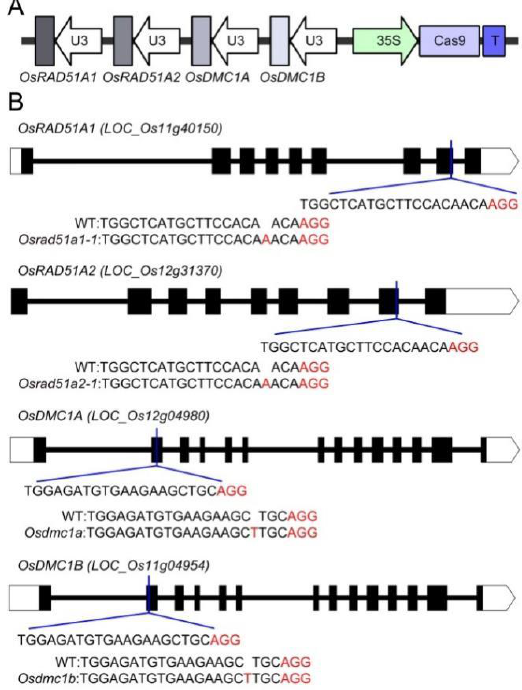
Figure 1. Targeted mutagenesis of OsRAD51 and OsDMC1 using the CRISPR/Cas9 genome editing system. ( A ). Strategy of vector construction for editing the rice RAD51 and DMC1 genes. ( B ). Regions in OsRAD51 exon 8 and OsDMC1 exon 2 were targeted by the CRISPR/Cas9 system. The positions of the sgRNAs are shown under the exons (black boxes) and the mutated sites in the mutants are shown beneath the genes aligned with the wild-type (WT) sequences. The PAM (protospacer adjacent motif) sites are shown in